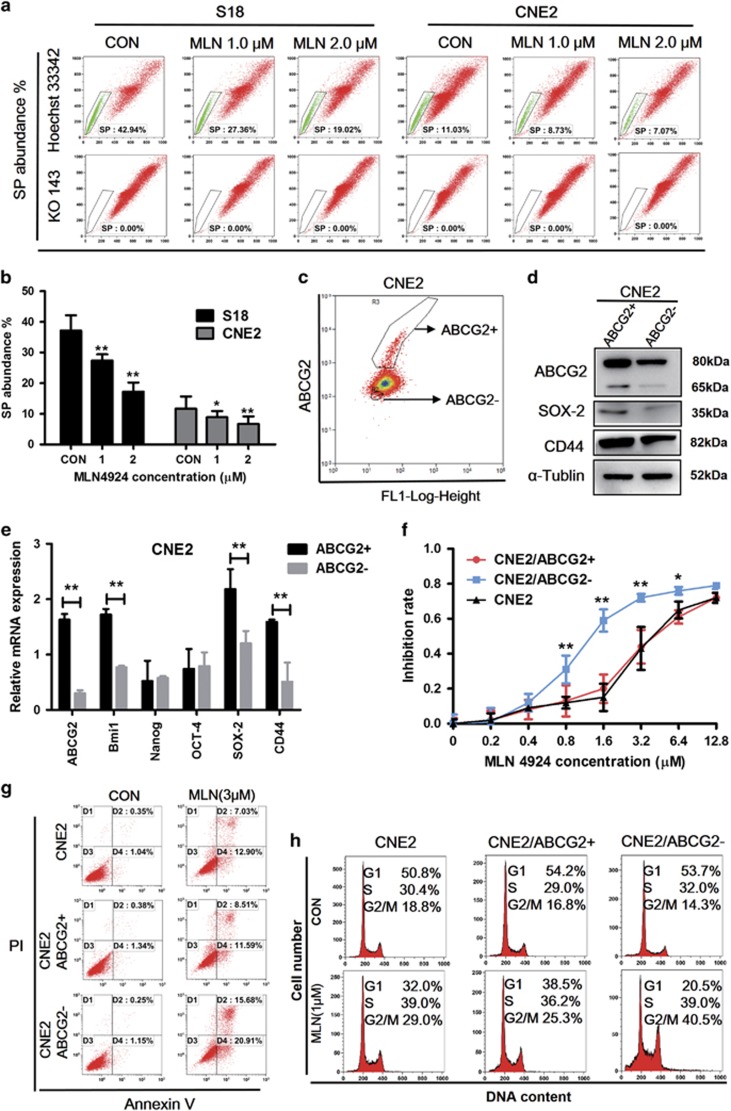
MLN4924 attenuates SP rate and inhibits the CSCs and the non CSCs of human NPC cells. (a,b) The SP assay for S18 and CNE2 subjected with MLN4924 in the indicated concentration for 48 h. (c) CNE2 was treated by ABCG2 antibody using FACS; ~5% of the ABCG2+/High and ABCG2-/Low cells were sorted. (d,e) ABCG2+/High and ABCG2-/Low cells were tested the expression of ABCG2, CD44, SOX-2, OCT-4, Bmi1, Nanog using mRNA, and WB. (f) CNE2, CNE2/ABCG2+ and CNE2/ABCG2− cells were treated with various concentrations of MLN4924 for 72 h after sorting and cultivated for one generation. Cell viability was assessed by MTT assay. (g) The indicated cells were treated with MLN4924 (0, 3 μM) for 48 h and test for apoptosis. (h) CNE2, CNE2/ABCG2+ and CNE2/ABCG2− cells were harvested for cell cycle analysis after MLN4924 treatment for 48 h. Data are presented as means ±S.E.M. of three independent experiments. *P<0.05, **P<0.01